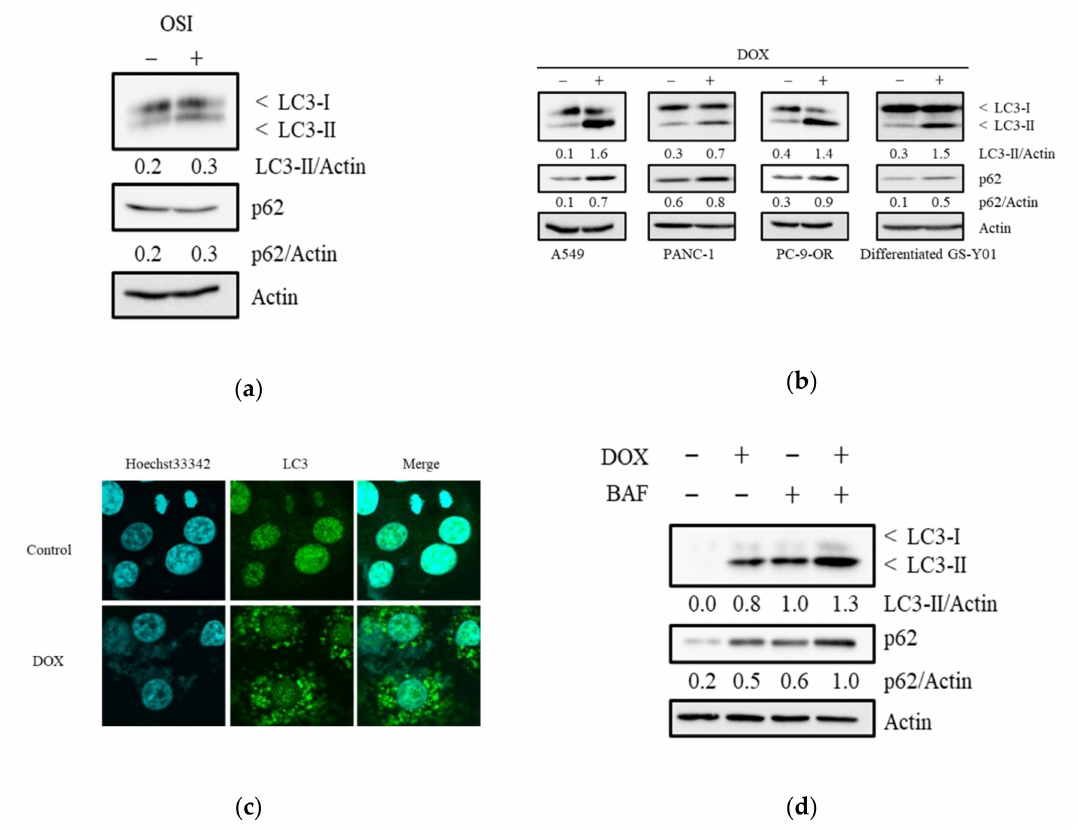
Figure 3. Doxazosin activates autophagy. Cells were treated ( a ) with / without 2 µ M osimertinib (OSI) (A549 cells); ( b ) with / without 15 µ M doxazosin (DOX); or ( d ) with / without doxazosin in the presence / absence of 10 nM bafilomycin A1 (BAF) (A549 cells), for 3 days, and then subjected to an immunoblot analysis for autophagic markers. A549 cells were treated with / without 15 µ M DOX for 3 days, and then subjected to an immunofluorescence analysis ( c ). The relative density was shown below each band of